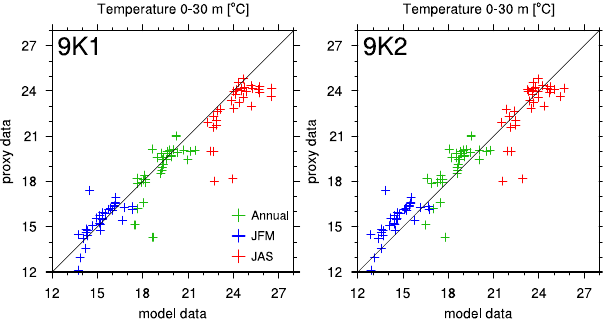
Fig. 20. Comparison of modelled T 0 − 30 with T 0 − 30 reconstructed from proxy data (Kucera et al., 2011) for 9K1 (left) and 9K2 (right). Annual mean, winter (JFM) and summer (JAS) are considered.